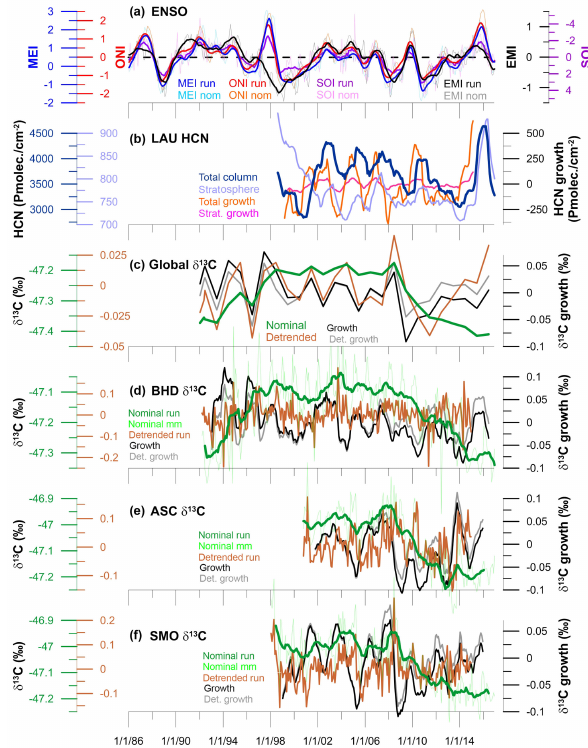
Figure 3. Selected time series of ENSO indices, HCN, and δ 13 CH 4 . Panels from top to bottom: (a) multivariate ENSO Index (MEI), Southern Oscillation Index (SOI), Ocean Niño Index (ONI), and El Modoki Index (EMI) shown for nominal literature data and their 12-month running means. (b) HCN records as 12-month running means from LAU for total atmospheric column and stratosphere (12–100km) and respective growth rates. (c) Global annually av- eraged δ 13 CH 4 according to Schaefer et al. (2016) updated to end of 2016; nominal and detrended values and their respective growth rates. (d) δ 13 CH 4 from BHD; monthly means, 12-month running mean, and detrended 12-month running mean, as well as nominal and detrended growth rates. (e) δ 13 CH 4 from ASC. (f) δ 13 CH 4 from SMO. ASC and SMO display same records as for BHD. Note scale differences between all δ 13 C axes to accentuate variability for comparison with